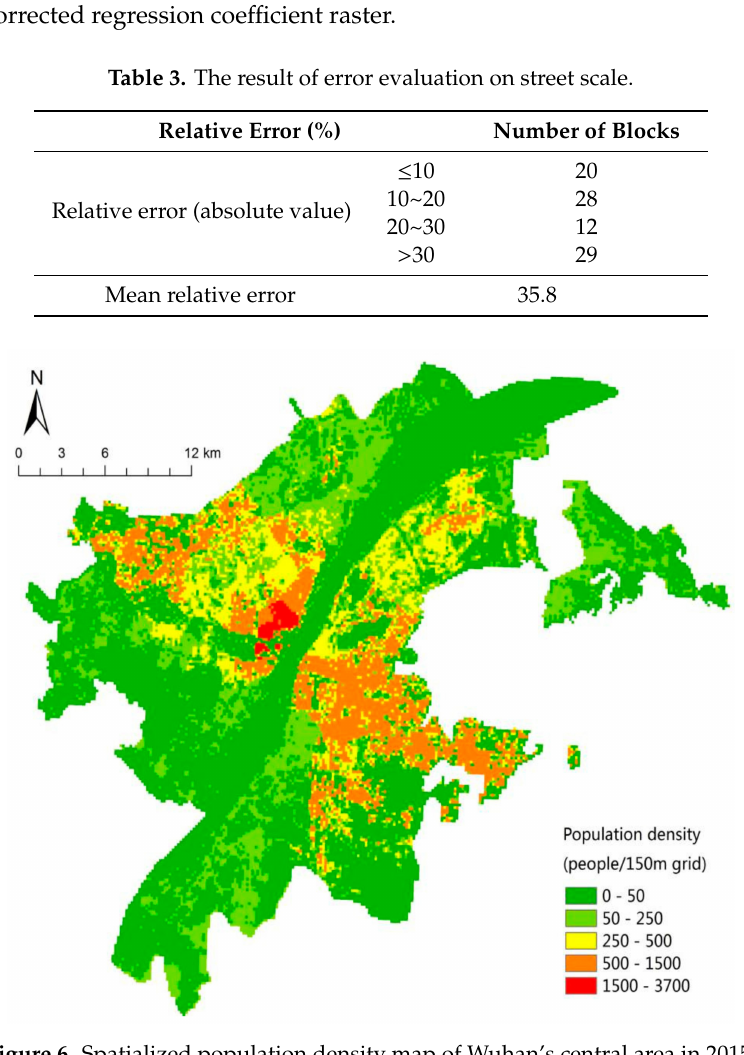
Figure 6. Spatialized population density map of Wuhan’s central area in